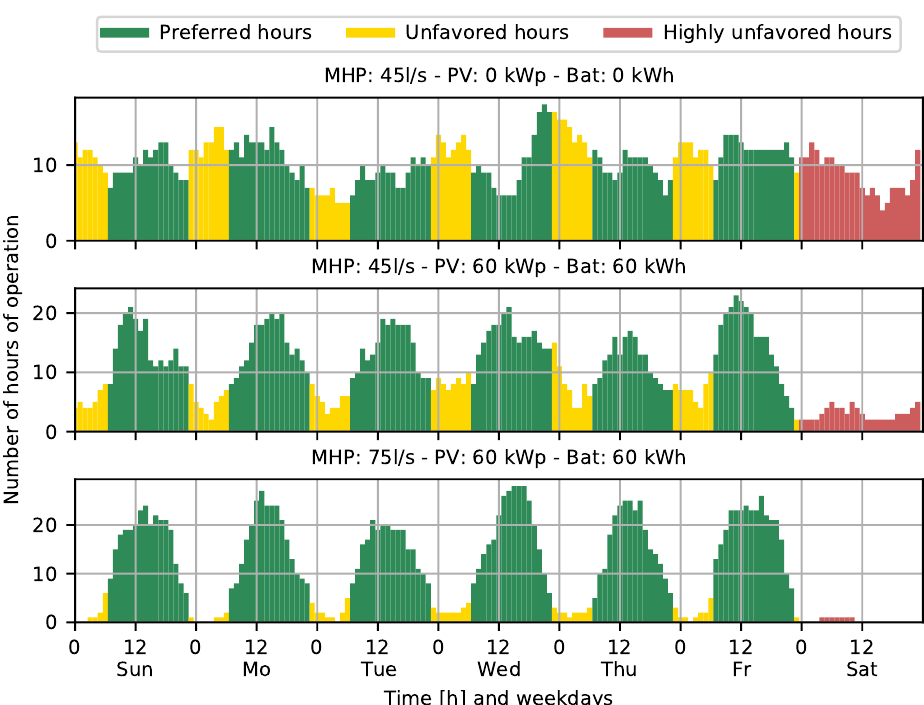
Figure 11. Sum of operating hours of the beverage production for each hour of the week over the period of one year—three exemplary